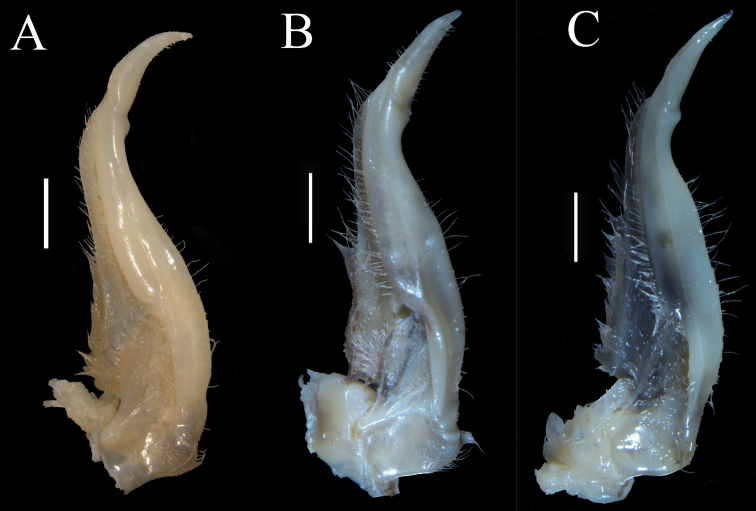
The ventral view of left G1 AIndochinamon
malipoense sp. nov. holotype, male, 53.0 × 42.7 mm, NNU 180505 BIndochinamon
tannanti male, 43.3 × 34.9 mm, NNU 180801 CIndochinamon
changpoense male, 44.1 × 35.6 mm, NNU 161701. Scale bars: 1.0 mm.